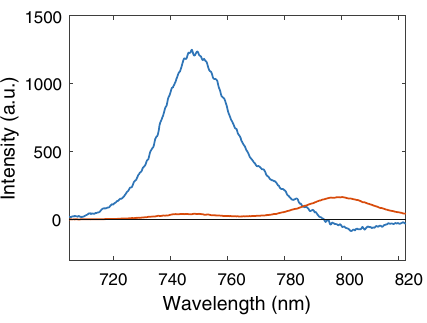
Figure 5. Decay-associated spectra of the two slowest fluorescence decay components resolved for the chlorosomes from Cfl. aurantiacus at aerobic conditions: 18.4 ps (blue line) and 234 ps (red